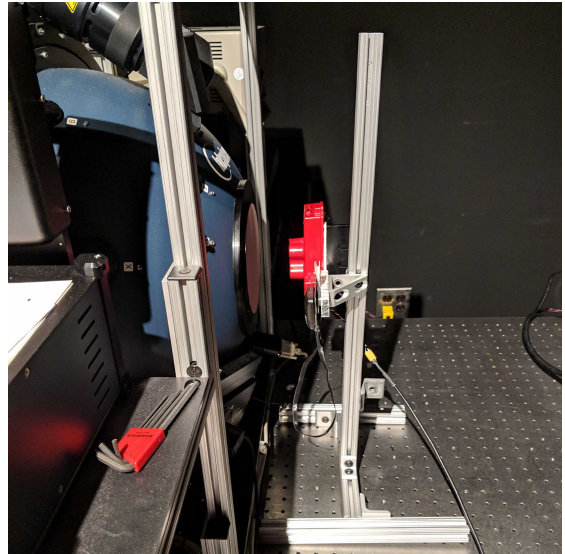
Figure 5. Radiometric calibration data capture setup. RedEdge-3 sensor is placed in front of the exit port of the integrating sphere. Sensor is placed far enough away to avoid stray light issues but close enough for all channels to be completely filled. RedEdge is attached to a custom made rig which allowed for both lateral and vertical